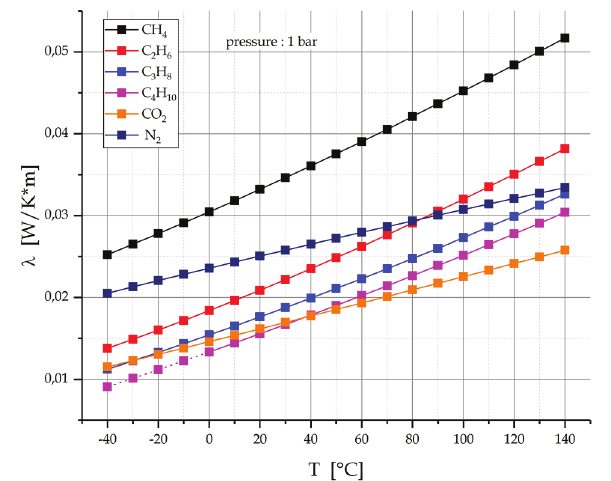
Fig. 1. Temperature dependency of the thermal conductivity λ for different pure